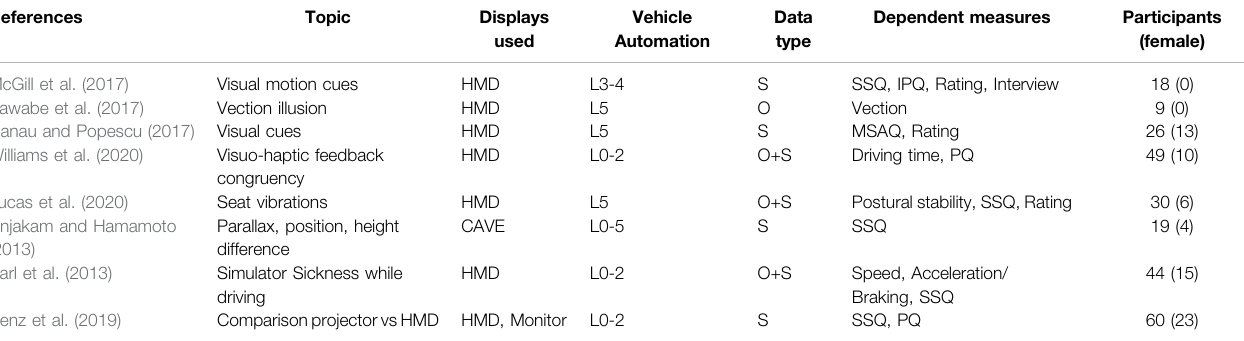
TABLE 9 | Summary of user studies in Simulator and Motion Sickness application